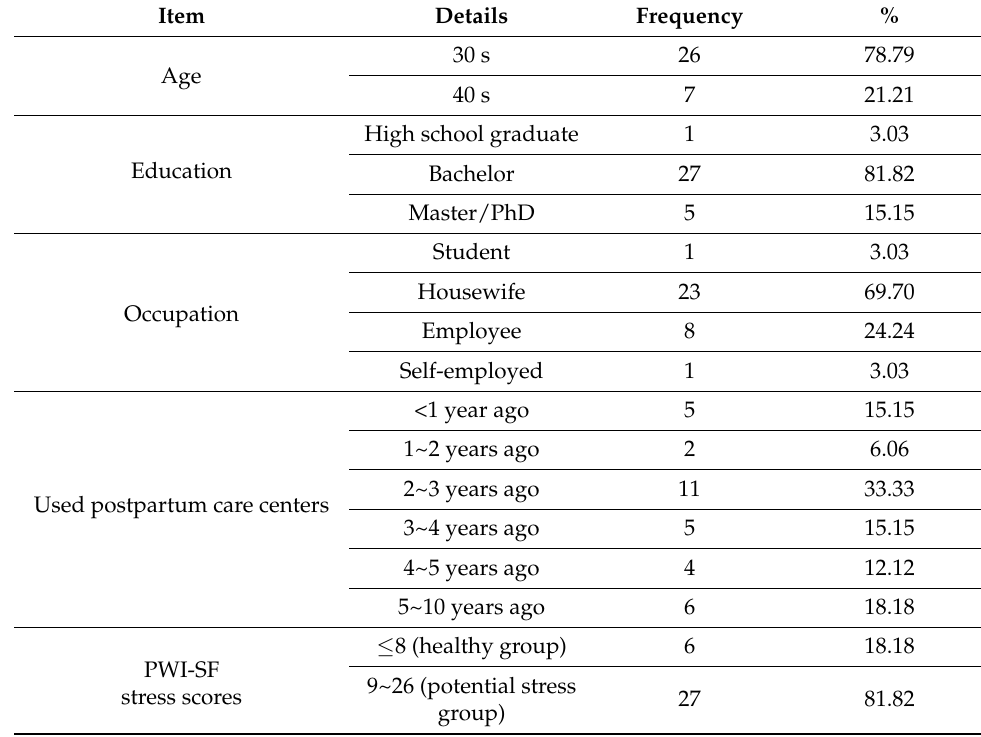
Table 2. Participants’ general characteristics and stress scores ( n =